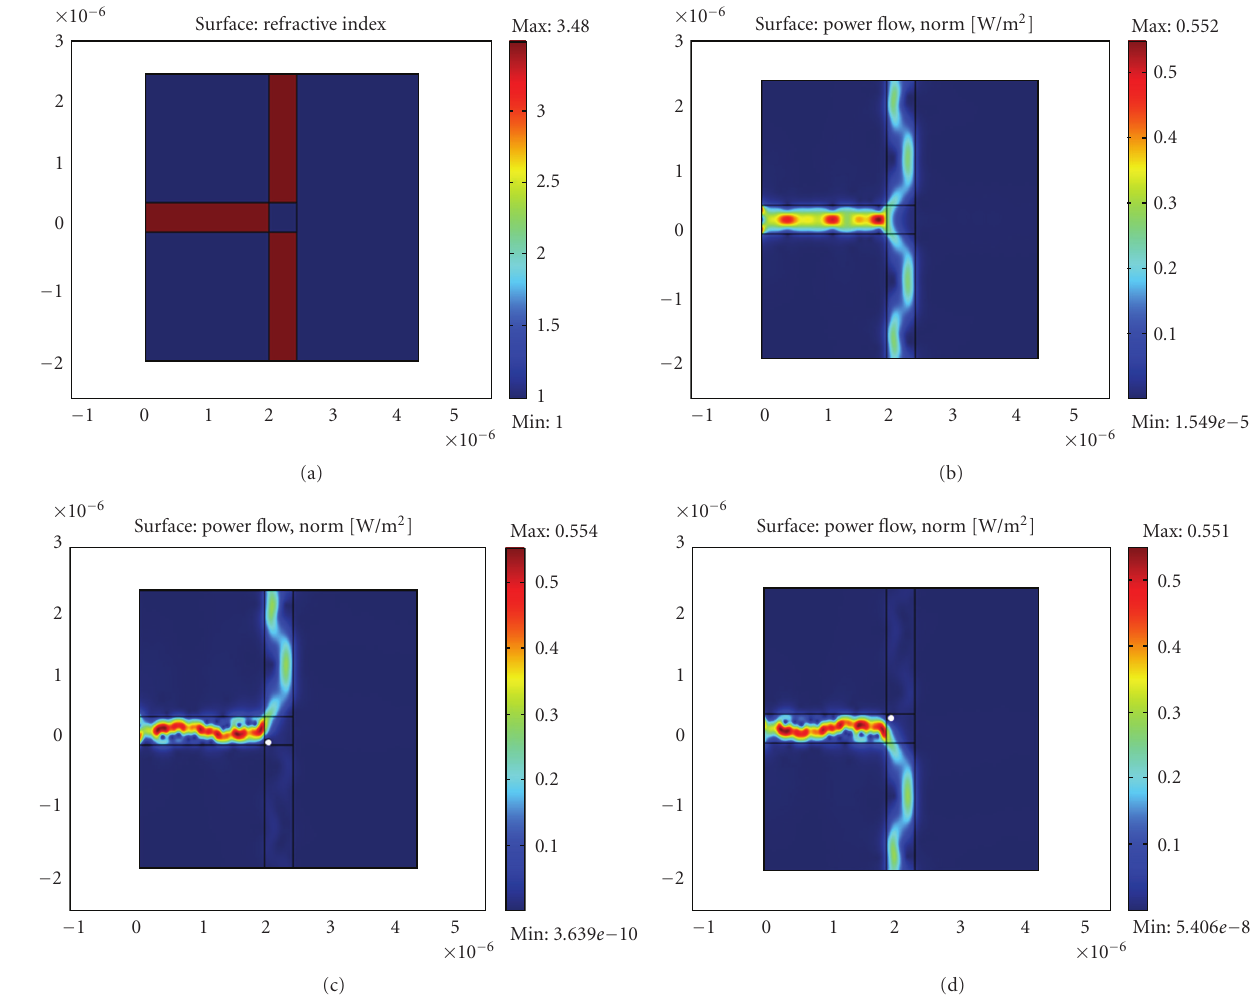
Figure 3: Numerical simulation. (a) Refractive index of the simulated device. (b) The power flow distribution along the “Y coupler” without the particle. (c) and (d) The power flow distribution along the “Y coupler” waveguide while the gold nanoparticle ( σ = 3 · 10 7 [S/m]) is placed in the lower and upper part of the air gap,